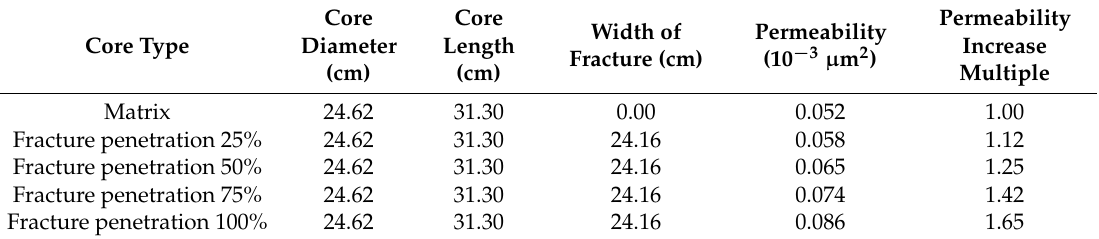
Table 2. Physical parameters of the cores with different penetration extents.